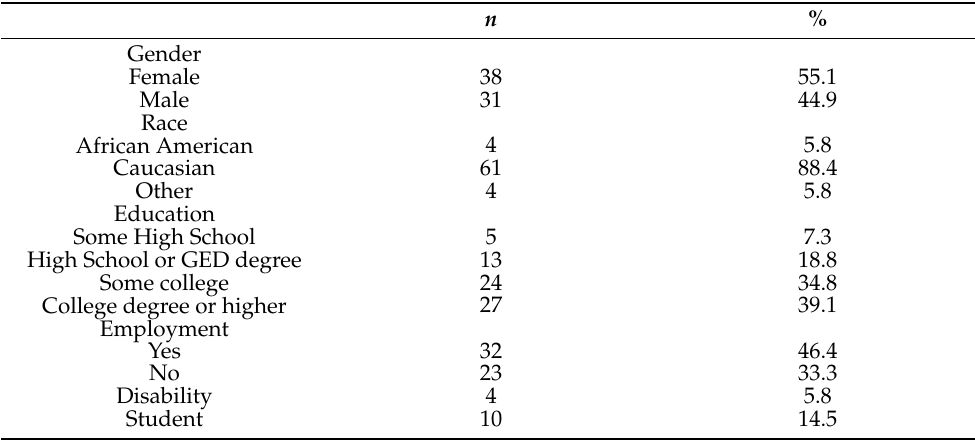
Table 1. Demographic characteristics of the